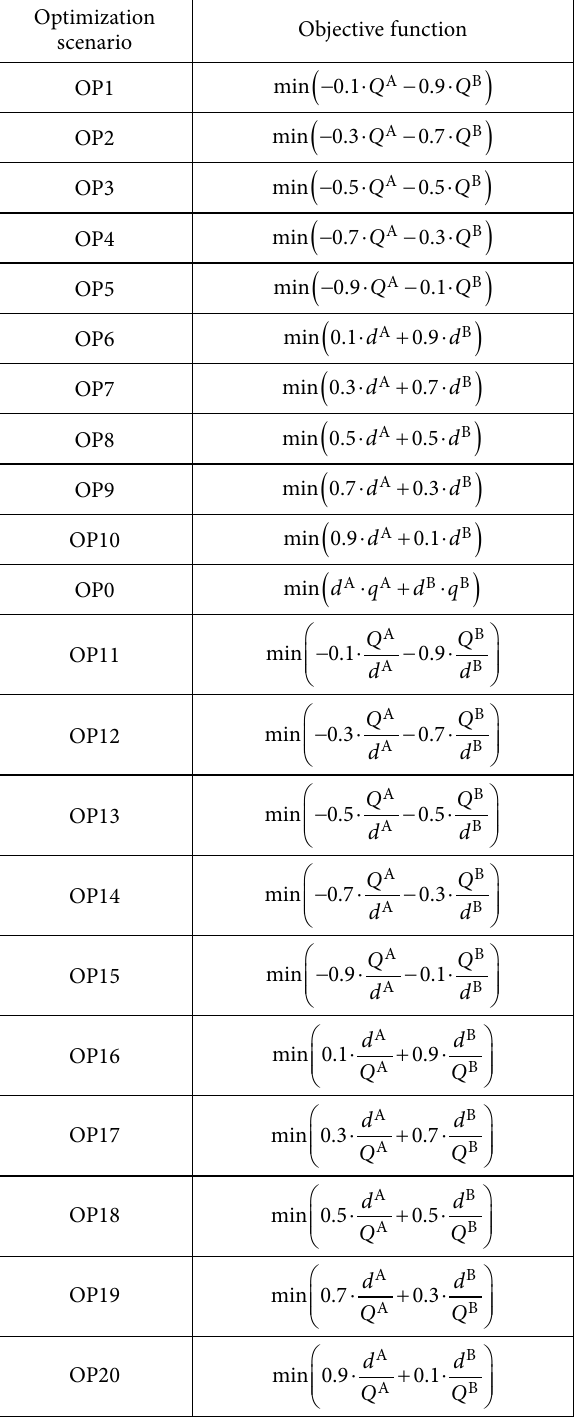
Table 3. Optimization scenarios and their objective functions Optimization scenario